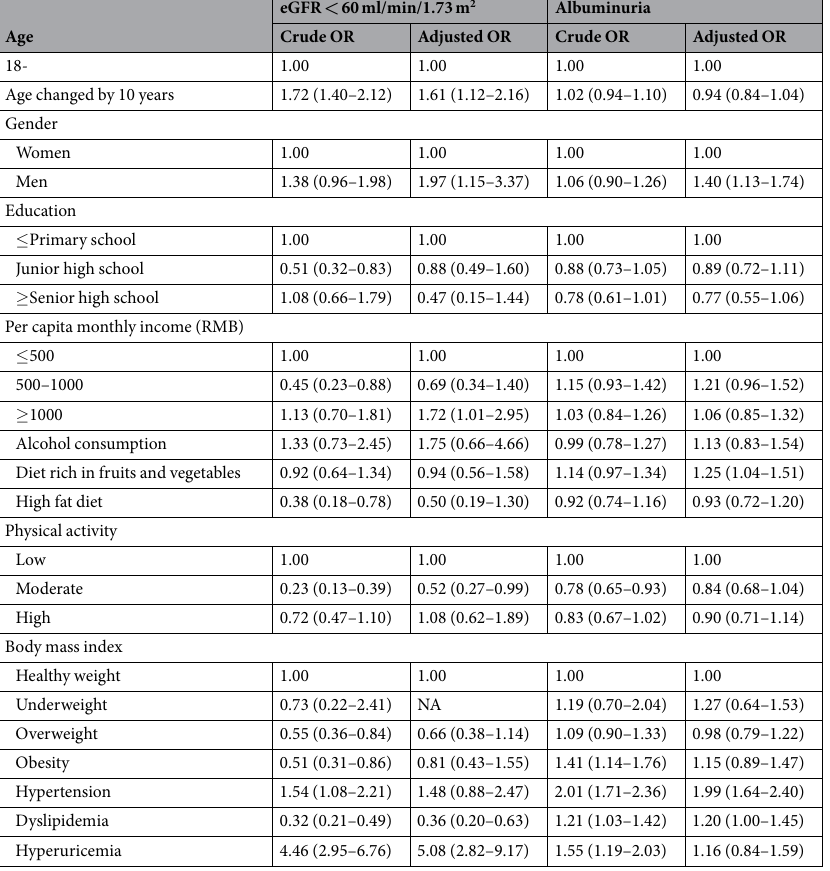
Table 7. Risk factors associated with indicators of renal damage in participants with diabetes. Note: Data were crude and multivariable-adjusted odds ratio (95% Confidence Interval). Abbreviation: DKD, diabetic kidney disease; NA, not applicable. Reference level: Gender = Woman; Education = Primary school; Per capita monthly income = 500 –; Alcohol consumption = No; Diet rich in fruits and vegetables = No; High fat diet = No; Physical activity = Low; Body mass index = Healthy weight; Diabetes = No; Hypertension = No; Dyslipidemia = No; Hyperuricemia =